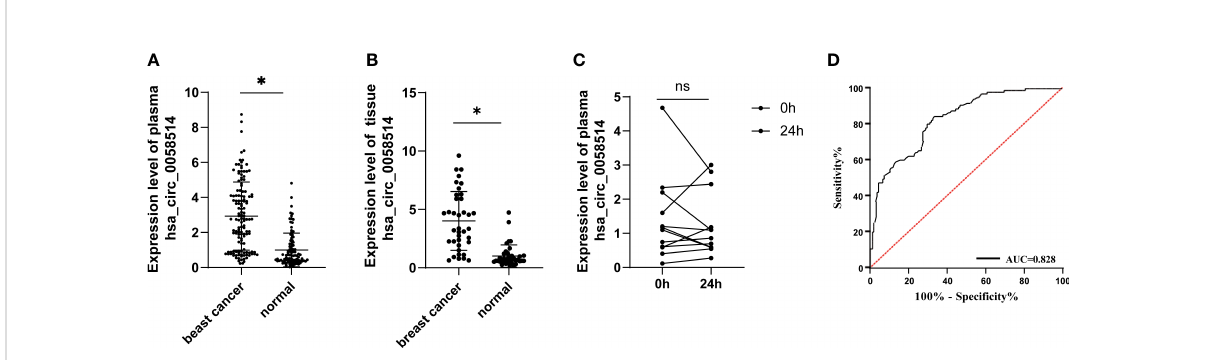
FIGURE 2 The expression level of hsa_circ_0058514 was higher in both plasma and cancer tissues of BC patients than healthy subjects. (A) The expression level of hsa_circ_0058514 detected in plasma and cancer tissues. (B) The stability experiment of hsa_circ_0058514 in plasma. (C) The stability experiment of hsa_circ_0058514. (D) The ROC curve of hsa_circ_0058514. *P < 0.05; ns, nonsigni fi